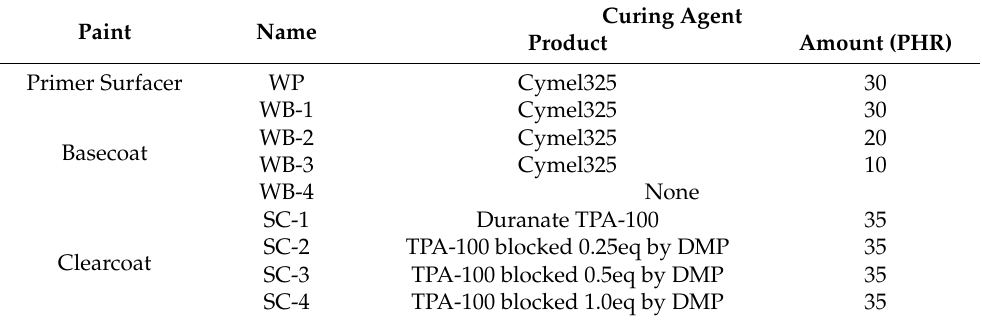
Table 1. Curing agents.